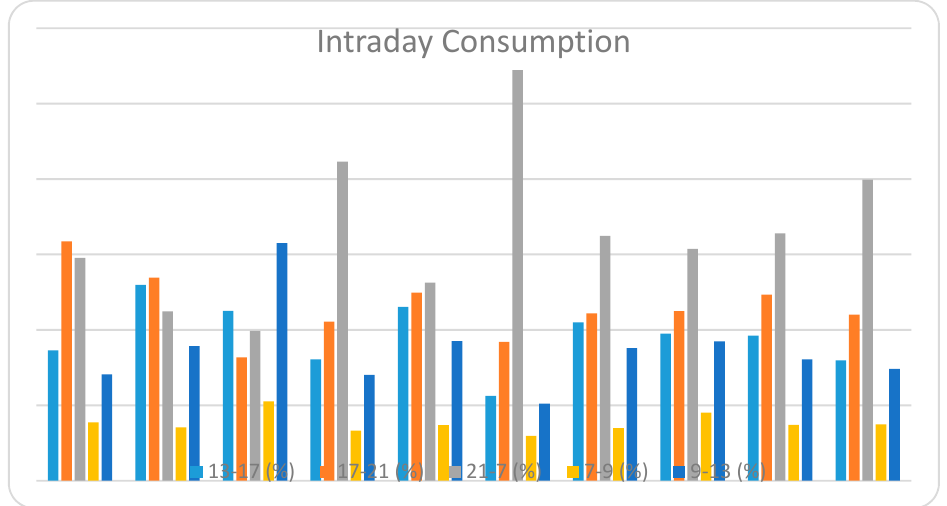
Figure 10. Intraday consumption.